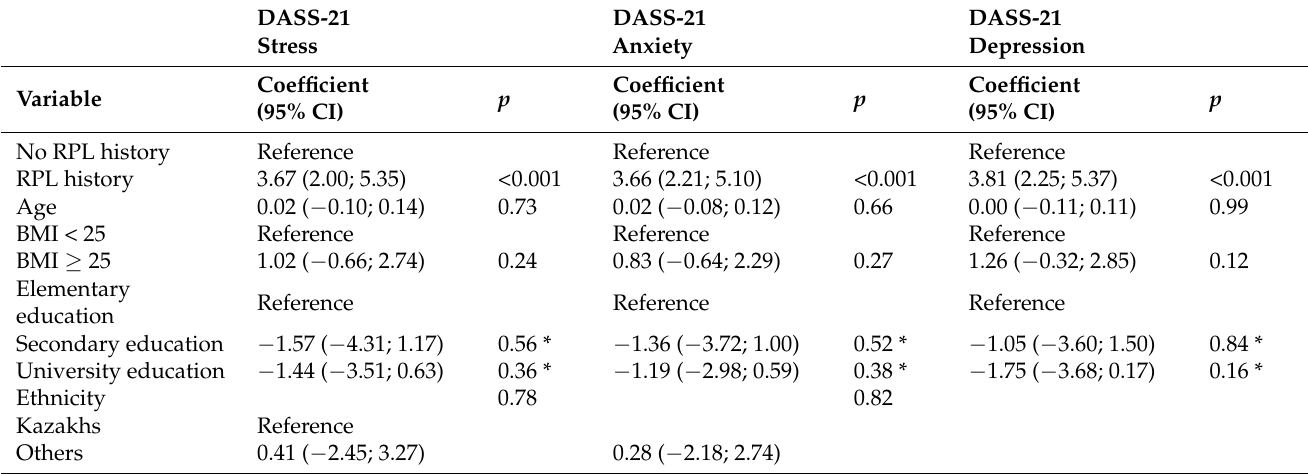
Table 3. Multivariable linear regression models of stress, depression, and anxiety levels compared between women from case and control